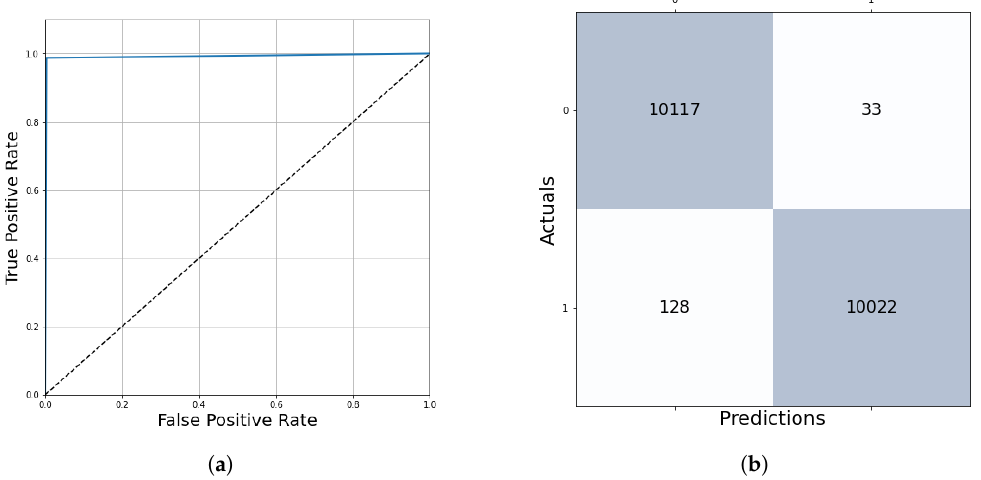
Figure 8. ROC curve and confusion matrix to evaluate the training performance. ( a ) Averaged ROC curve. ( b ) Confusion